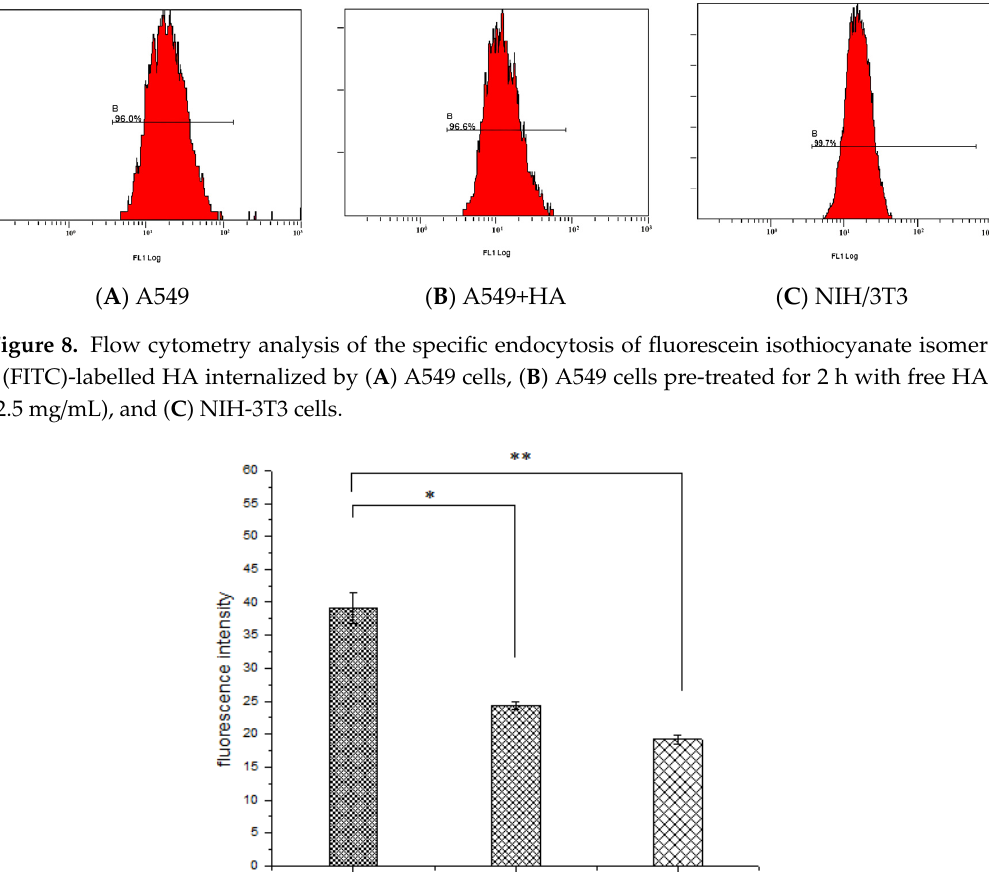
Figure 9. Fluorescence intensity of FITC-labelled HA in A549 cells, A549 cells pre-treated with free HA (A549 + HA), and NIH/3T3 cells. Data are shown as the mean ± standard deviation (SD) ( n = 3). Statistically significant differences are indicated by * ( p < 0.05) and ** ( p < 0.01).